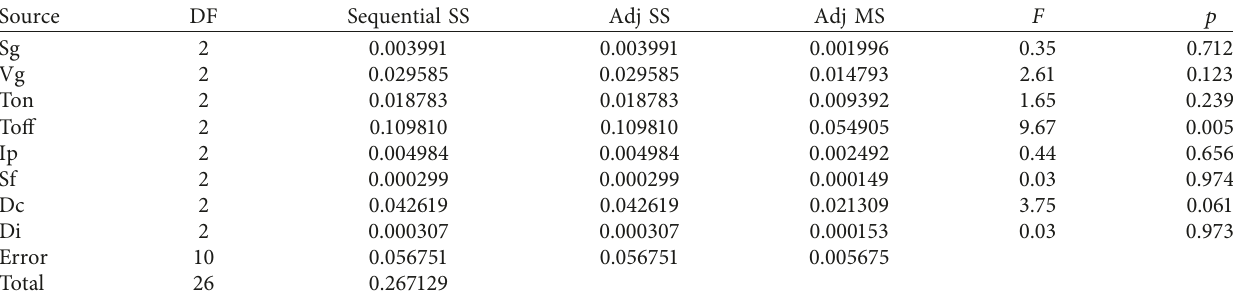
Table 17: ANOVA for c i using adjusted SS for tests.